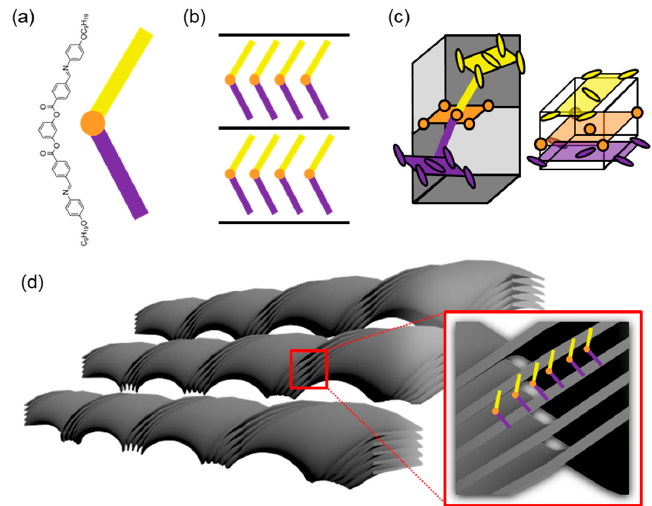
Figure 1. Formation of helical nanofilament (HNF) phase from bent-core LC molecules. ( a ) Chemical structure of typical bent-core LC molecule P-9-OPIMB (NOBOW). A center aromatic ring (orange) and two arm planes (yellow and purple) have three tilted planes within each molecule. ( b ) When cooled from an isotropic temperature, the NOBOW molecules form smectic layers. ( c ) Due to the three tilted planes in NOBOW, there is elastic stress within smectic layers, called an in-layer mismatch. The right panel represents the oblique herringbone lattices of each arm plane (yellow and purple circles) projected on to the center aromatic ring plane (orange circles). ( d ) In order to relieve the stress, layers are bent to be an HNF with saddle-splay curvature.